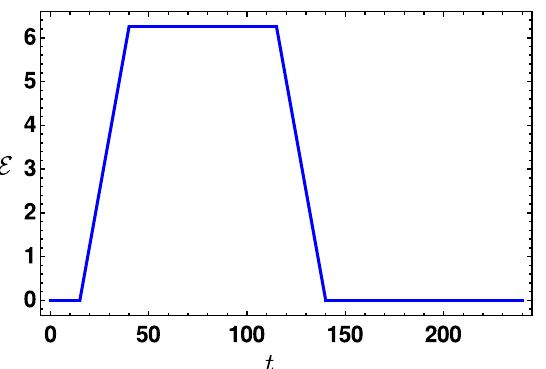
Figure 7 . Holographic entanglement negativity E vs time t is plotted for two disjoint intervals of lengths ℓ 1 = 50, ℓ 2 = 200 with the seperation length l s =